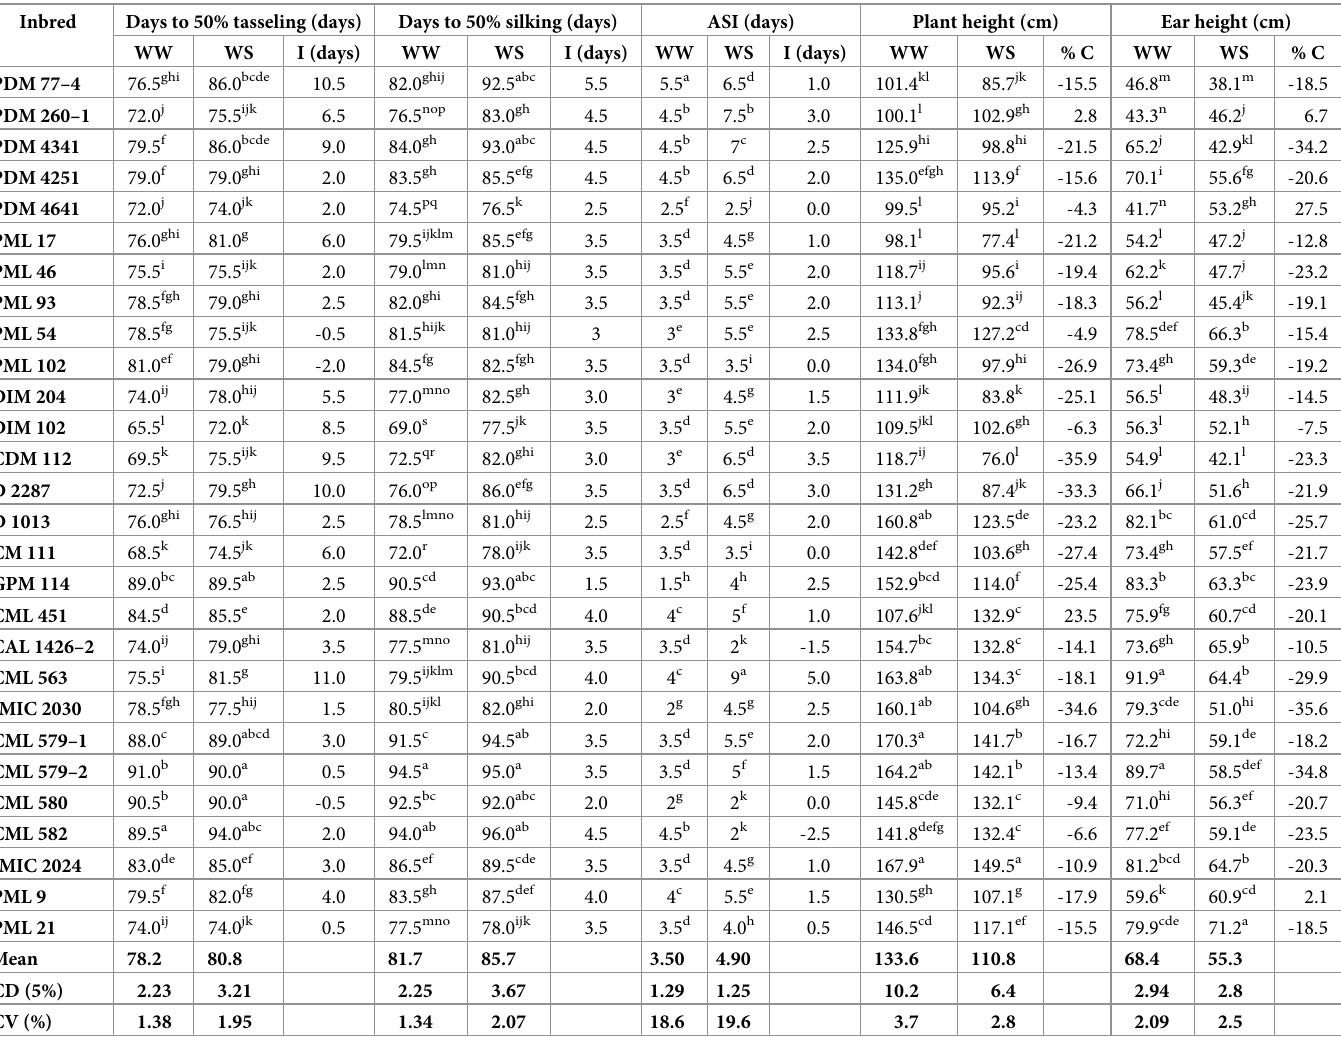
Table 6. Performance of corn inbreds and per cent reduction over well watered for phenological traits. Inbred Days to 50% tasseling